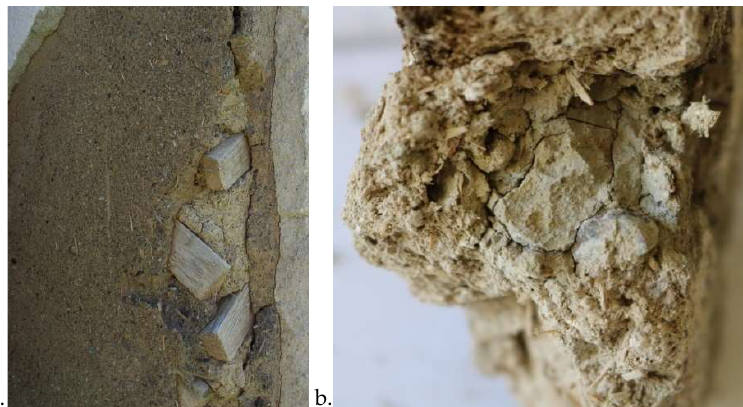
a. b. Figure 2. ( a ) Clay mortar with straw in an inner layer between wooden slats on a rendered timber house in Sweden. Photo: Kristin Balksten. ( b ) Old mortars from a rendered facade in Visby. It contains clay, a little lime and straw, and was used as mortar in the inner 5 cm layer between wooden slats, behind a lime render. Photo: Sofie Nygren.